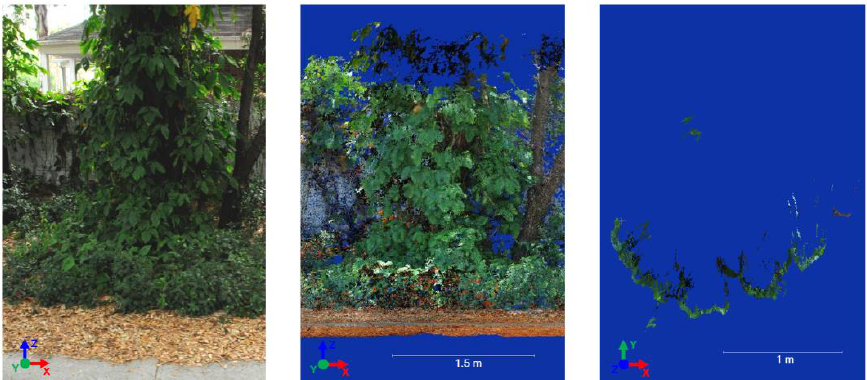
Figure 7. An individual photo of a stem occluded by vegetation ( left ), the point cloud model of the stem ( center ), and the resulting diameter at breast height slice from this tree ( right ).